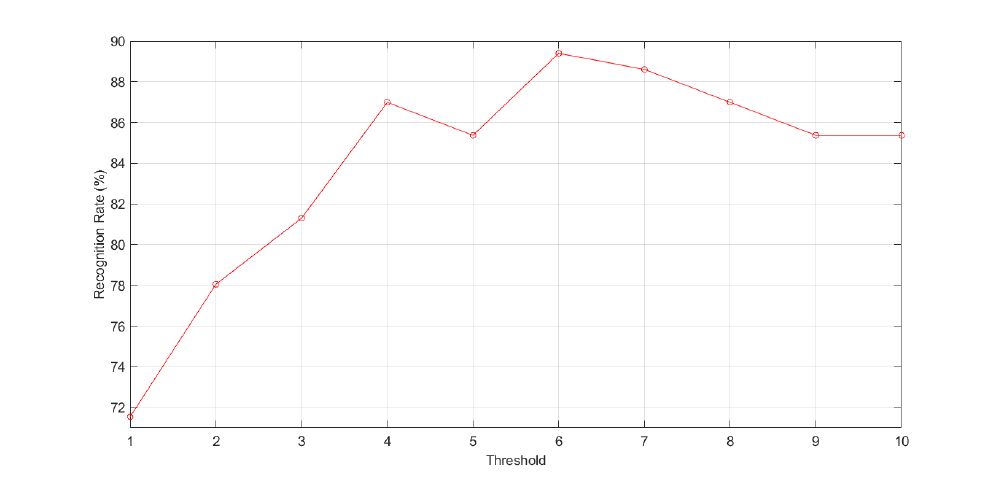
Figure 8. Recognition rate according to LTP threshold.